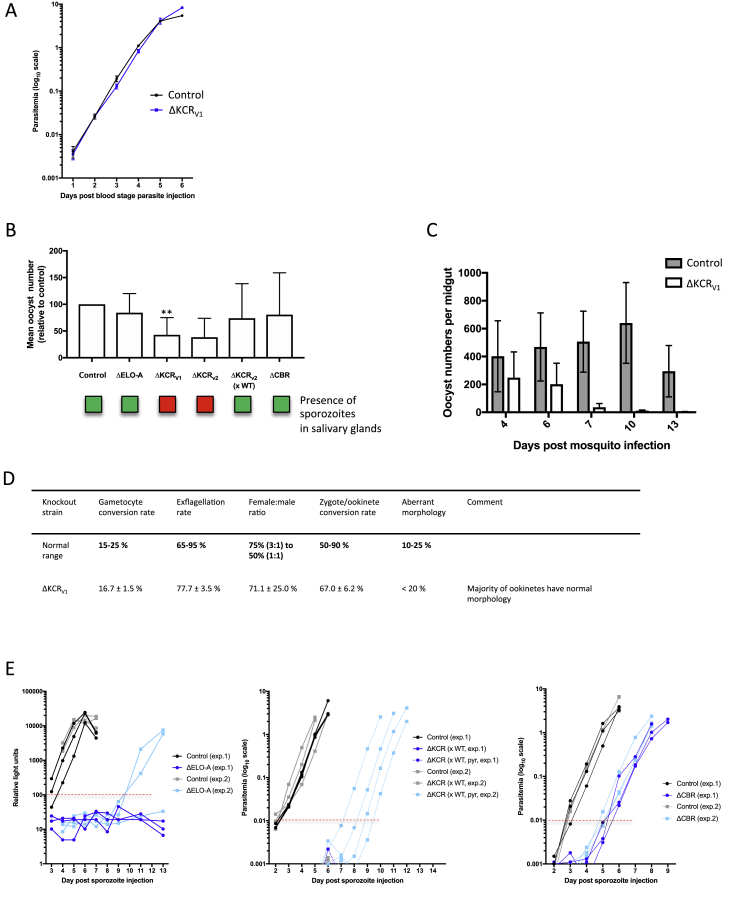
Phenotypic Analysis of Gene Knockout Mutant Parasite Lines Associated with the FAE Pathway, Related to Figure 6(A) Graph showing growth rate of ΔKCRv1 blood stage parasites in relation to control parasites, as shown as progression of parasitemia at successive days after injection of blood stage parasites. (B) Graph showing oocyst numbers (relative to control; set to 100%) at day 7 post infection for ΔELO-A, ΔKCRv1, ΔKCRv2, ΔKCRv2 (xWT) and ΔCBR parasites. Error bars indicate standard deviation. The results were statistically evaluated by a one-way analysis of variance (ANOVA) test with Dunnet’s multiple comparisons (∗∗p < 0.01). Boxes shown below the graph indicate the presence (green) or absence (red) of sporozoites from the salivary glands for each knockout strain between days 18 and 21 post-infection. (C) Graph showing oocyst numbers in the ΔKCRv1 parasite strain relative to the control on days 4, 6, 8, 10 and 13 post-infection. Error bars display standard deviation. (D) Table displaying sexual and mosquito stage phenotypic data for ΔKCRv1 parasites; gametocyte conversion rate, exflagellation rate, female: male ratio, zygote to ookinete conversion rate and percentage of ookinetes showing abnormal morphology. Data is shown in relation to normal ranges for such phenotypic assessments. (E) Graphs showing relative blood stage parasitemia for mice injected with ΔELO-A parasites (relative light units by luciferase assay) and parasitemia for mice injected with ΔKCRv2 (x WT) and ΔCBR parasites (based on FACS). Data from all mice (control and KOs) are shown for two independent experiments and lines are drawn for the relative light unit level or parasitemia considered as being the point at which a mouse has become positive.